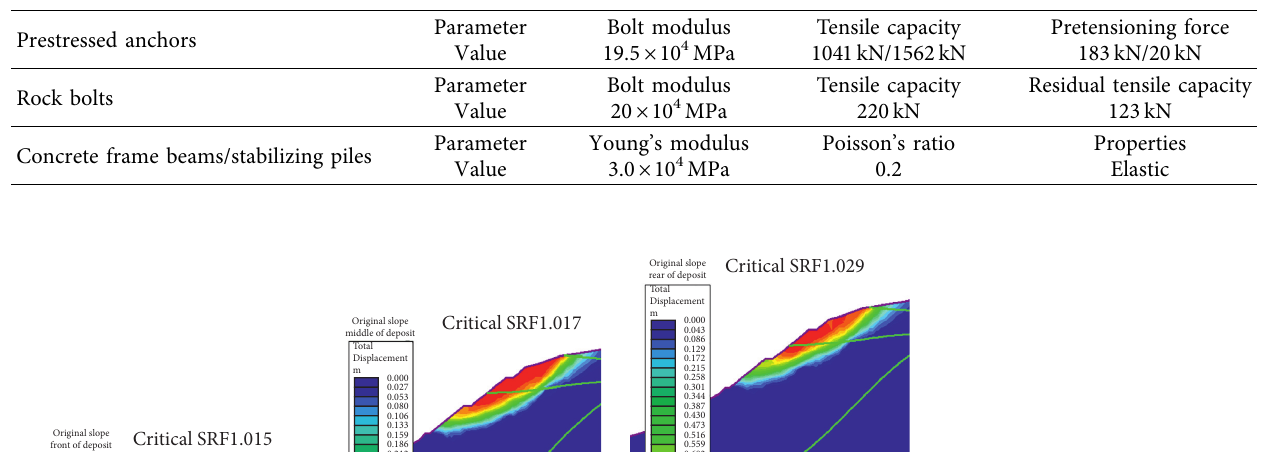
Table 2: Properties of structural elements adopted in the finite element model.